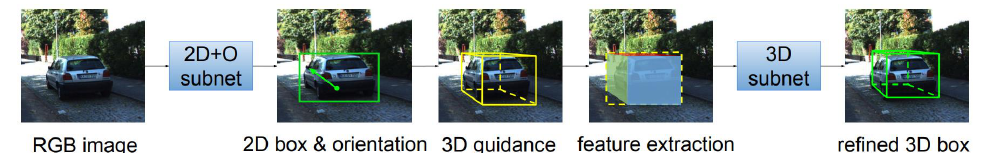
Figure 5. Overview of GS3D